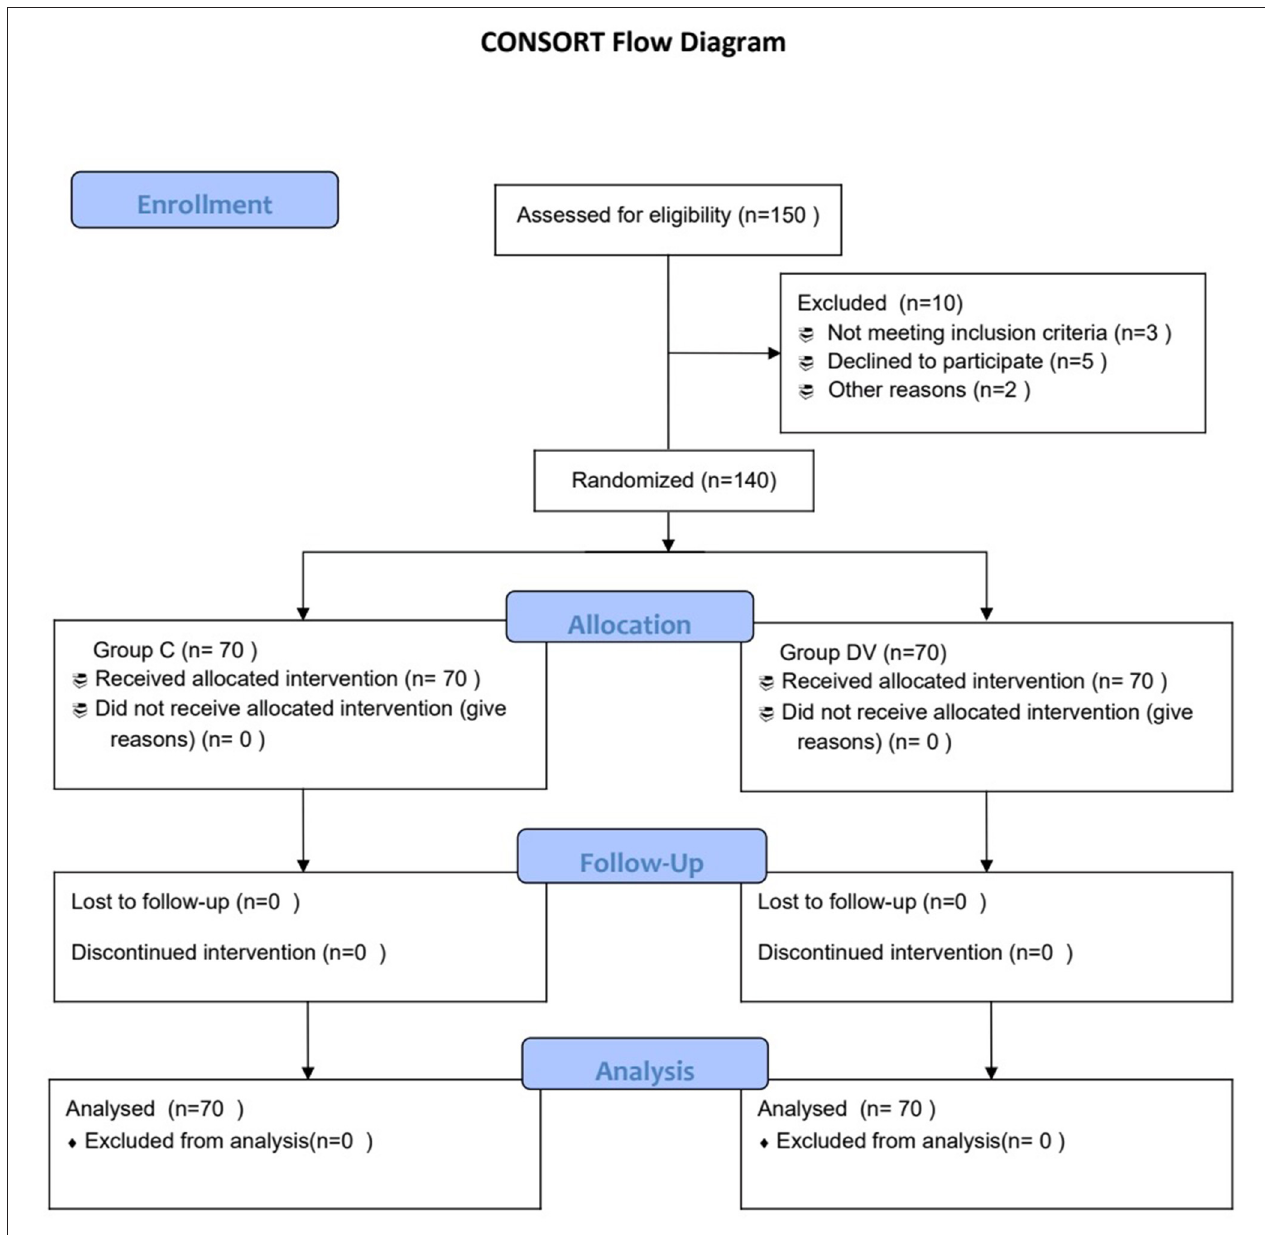
FIGURE 1 | Consort flow